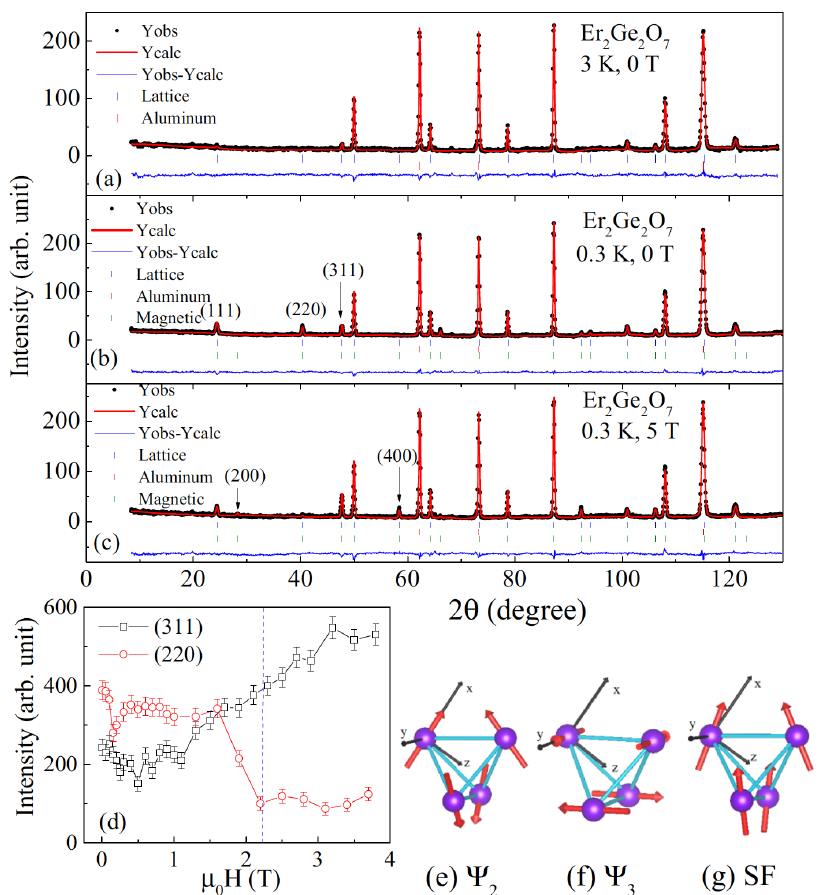
Figure 11. (color online) Elastic neutron scattering patterns and Rietveld refinements for EGO at ( a ) T = 3 K and H = 0 T, ( b ) T = 0.3 K and H = 0 T, and ( c ) T = 0.3 K and H = 5 T. ( d ) The field dependence of the (220) and (311) Bragg peaks intensities measured at T = 0.3 K; the critical field Hc is marked as the dashed line. The spin configurations for ( e ) Ψ 2 , ( f ) Ψ 3 , and ( g ) splayed ferromagnetic (SF) phases in the local coordination. From Ref.